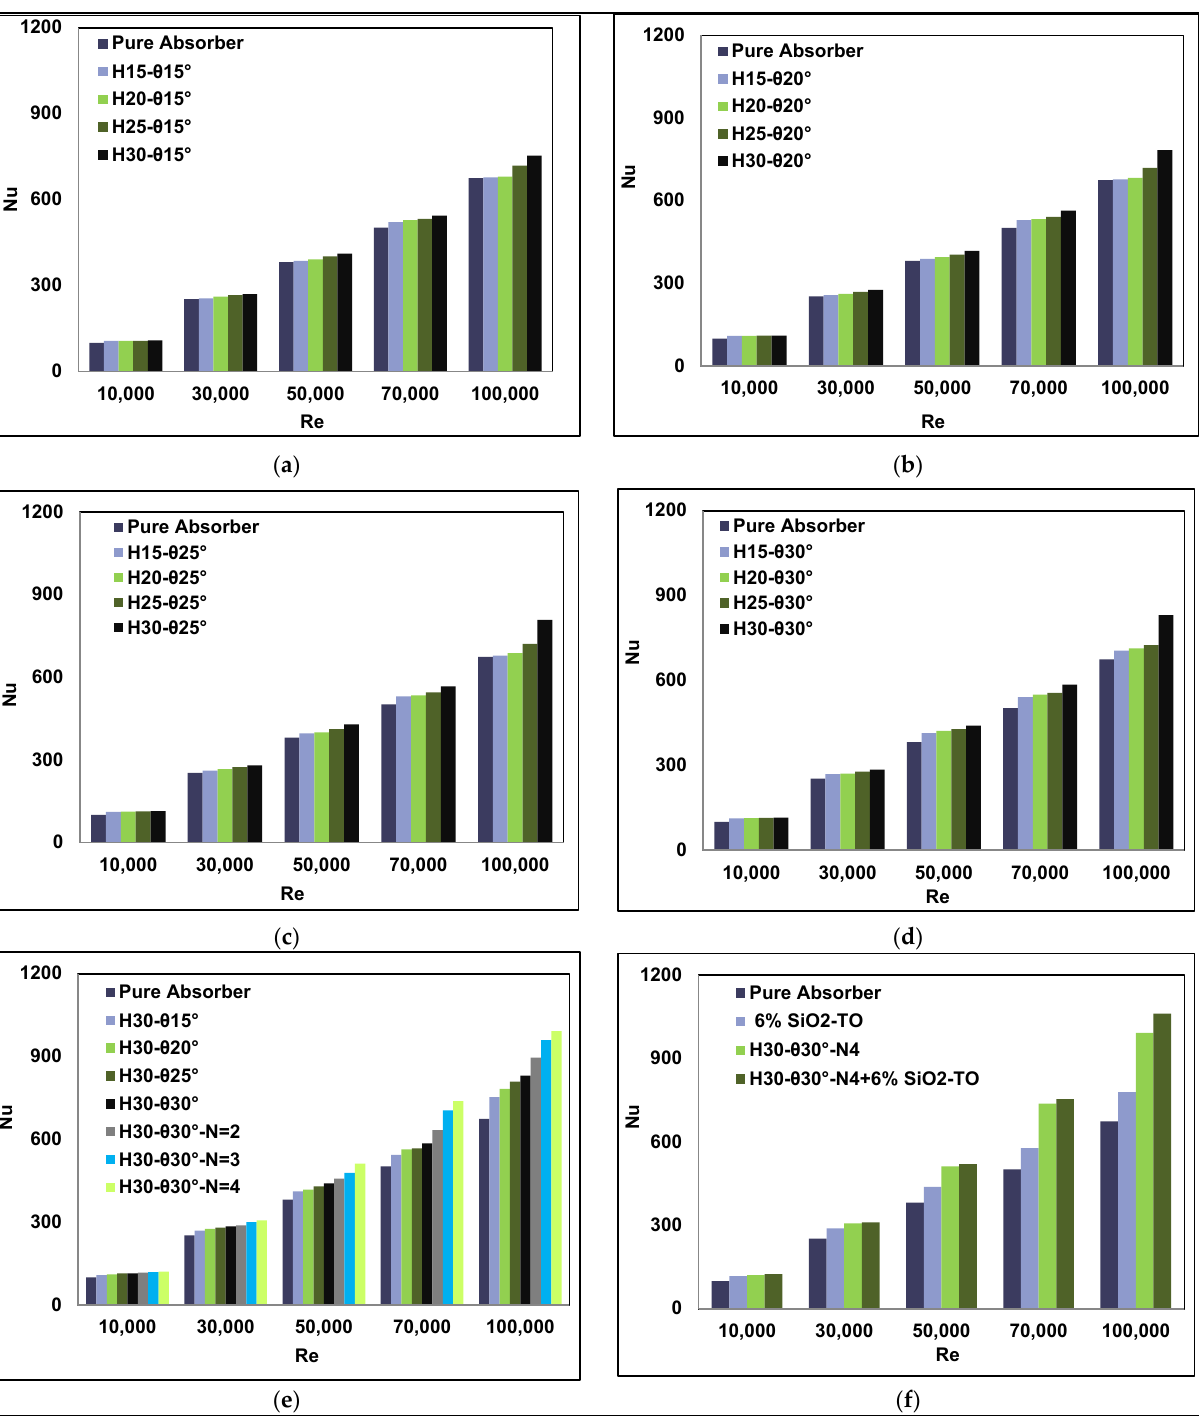
Figure 13. Effects of swirl generators geometries with/without nanofluids on heat transfer performance. ( a ) Pitch height variation with θ = 15°, ( b ) Pitch height variation with θ = 20°, ( c ) Pitch height variation with θ = 25°, ( d ) Pitch height variation with θ = 30°, ( e ) Pitch angle ( θ ) and number of inserts (N) variation with fixed pitch height, ( f ) Optimal configuration with and without nanofluids.